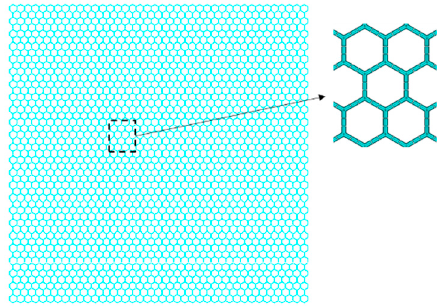
Figure 1. Graphene sheets with beam finite elements.